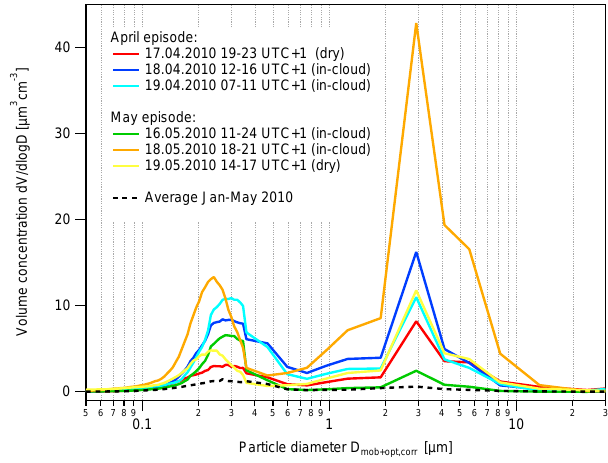
Fig. 2. Volume distributions observed at the Jungfraujoch during time periods with maximal influence by the volcanic aerosol plume. The abscissa represents mobility diameters below 0.5µm (SMPS measurements) and optical diameters above 0.5µm (OPC measure- ments).